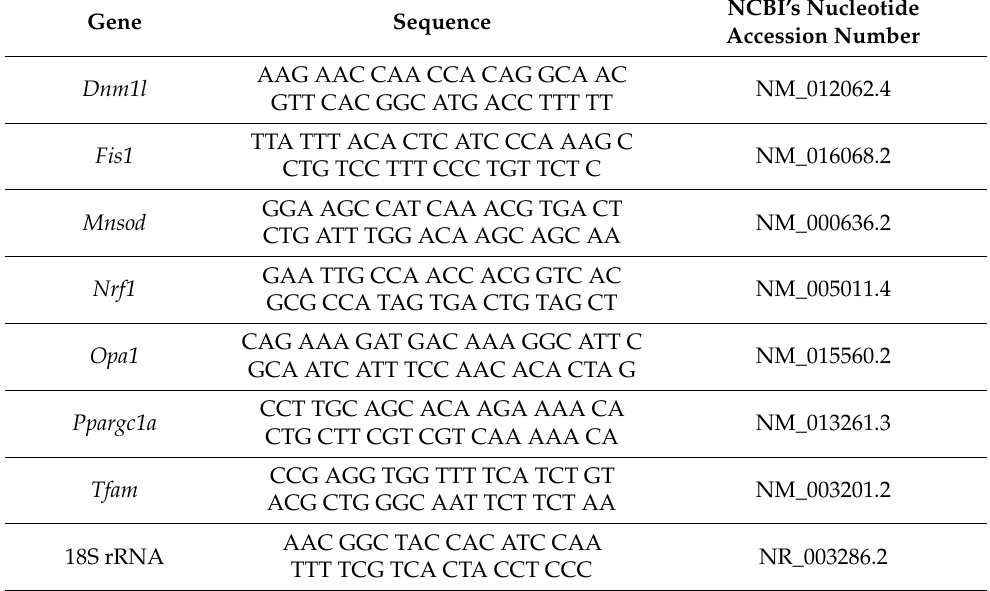
Table 1. Nucleotide sequences of primers used in